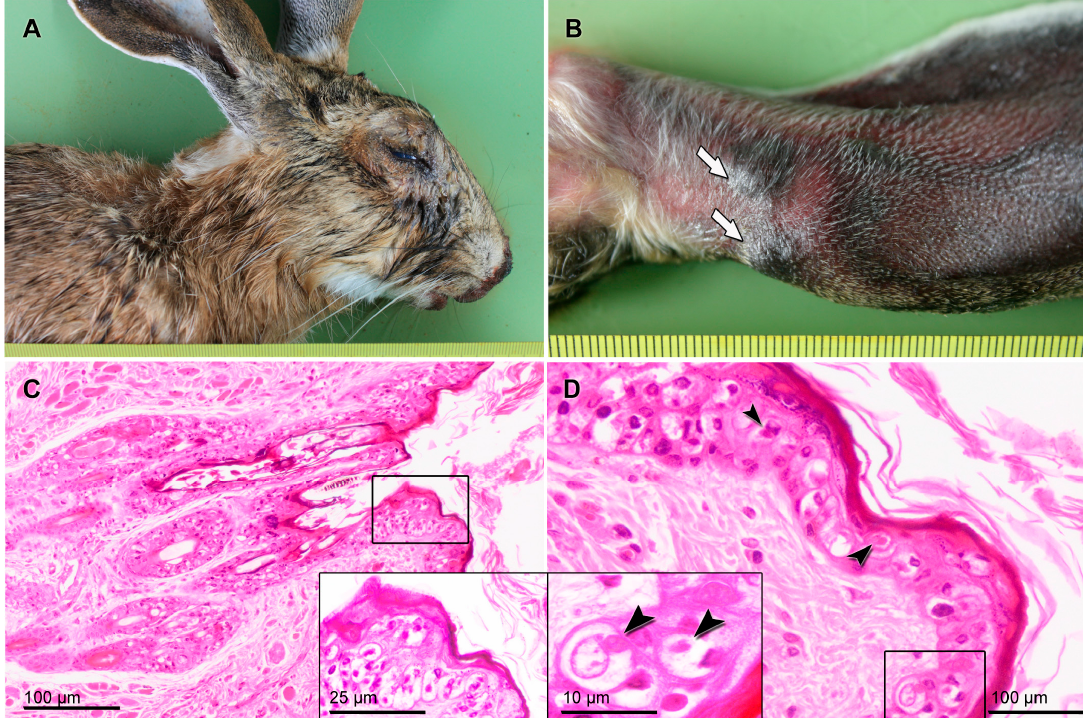
Figure 1. Iberian hare with myxomatosis-compatible lesions. ( A ) Blepharitis and conjunctivitis with seropurulent discharge. ( B ) Myxomas at the base of the left ear (arrows). ( C ) Severe acanthosis of the eyelid skin, with hyperkeratosis. ( D ) Ballooning degeneration of the epidermal cells, and intracytoplasmic eosinophilic inclusion bodies in the eyelid skin (arrowheads).